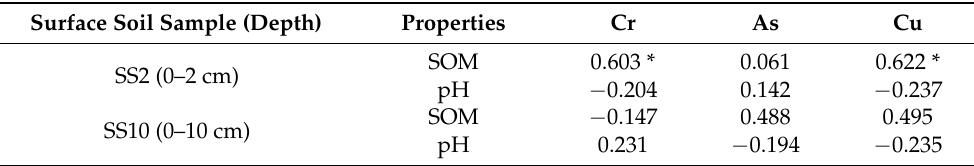
Table 4. Matrix of correlation coefficients between metal(loid)s and soil pH and SOM content in surface soils under CCA-treated